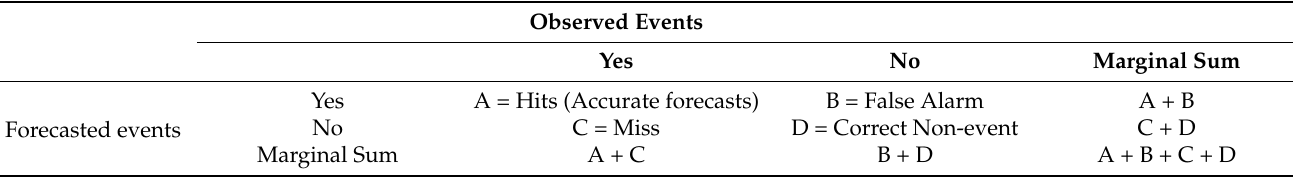
Table 2. Contingency table to define the criteria for contingency measures.